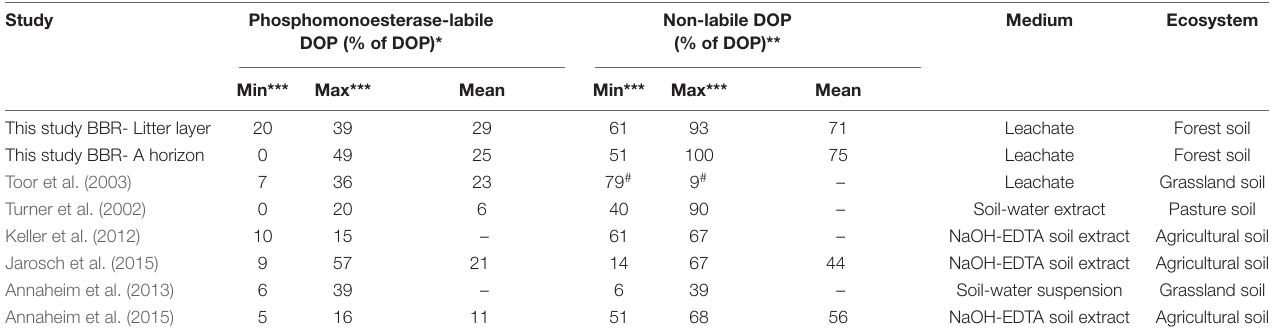
TABLE 3 | Results of enzyme addition assays conducted with phosphomonoesterase addition in 2013/2014 on soil solutions from the P-rich site Bad Brückenau (BBR), and results from enzyme addition assays from literature with leached soil solutions and soil extracts. Study Phosphomonoesterase-labile DOP (% of DOP)*